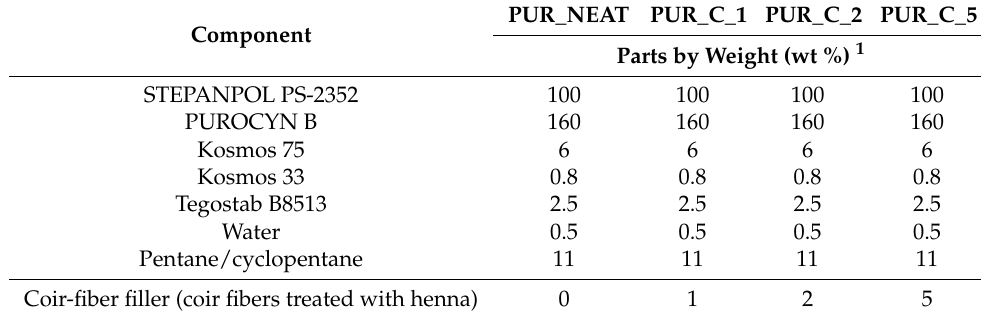
Table 1. Formulas of PUR composites developed in the study.